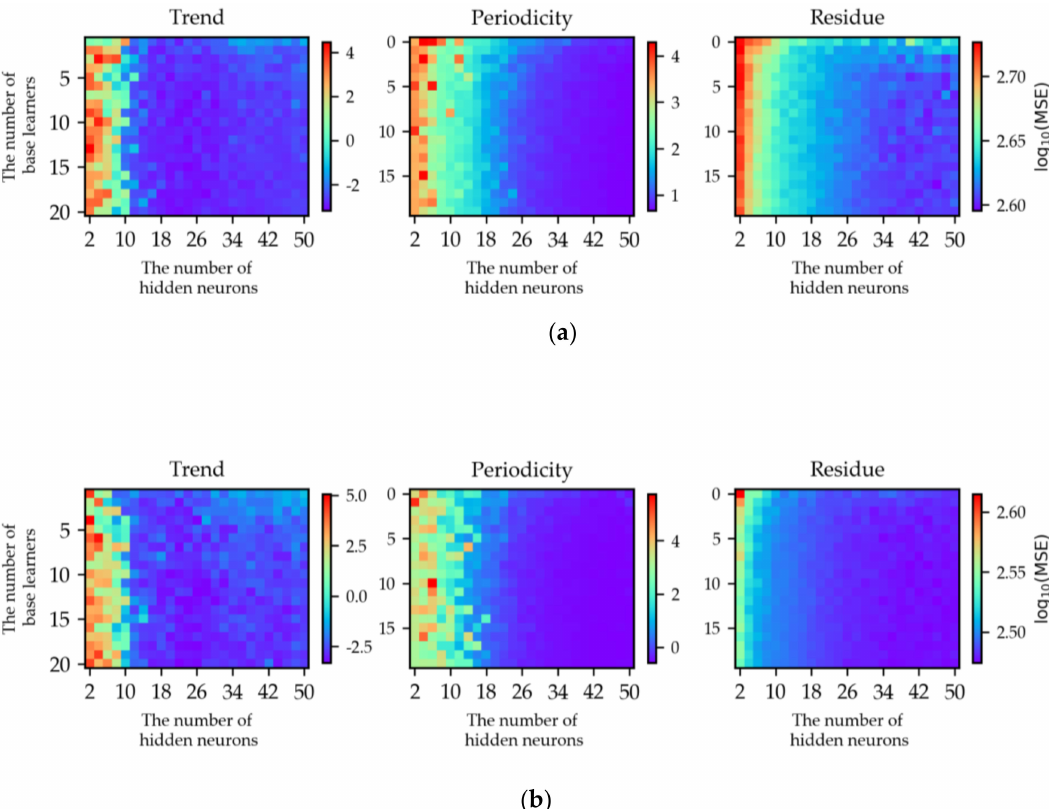
Figure 7. The process of hyper-parameter selection for SSA-AWELM (Q.R. Sta.): ( a ) exit passenger flow and ( b ) entrance passenger flow. Table 3. Average evaluation measures across all six prediction horizons. RMSE: root mean square error and MAE: mean absolute error. Q. R. Sta.: Qiangjiang Road Station and J. Sta.: Jinjiang Road Station. ARIMA: Auto Regressive Integrated Moving Average. ANN: Artificial Neural Network. LSTM: Long Short-Term Memory neural network. ELM: Extreme Learning Machine.